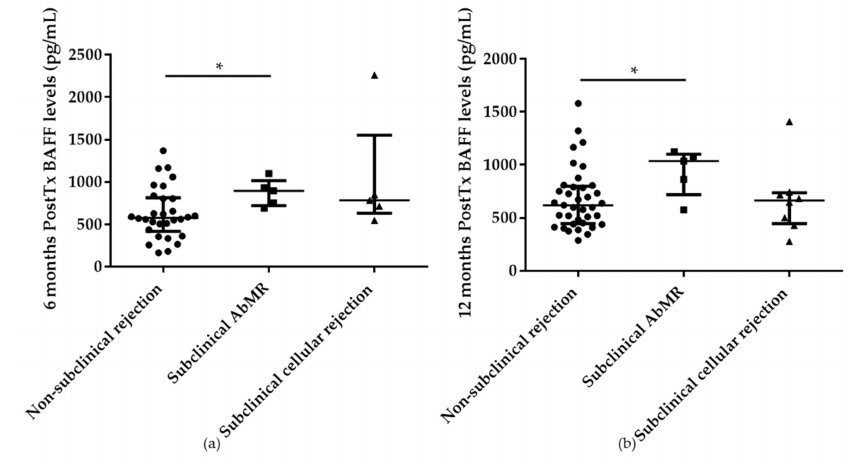
Figure 7. Higher BAFF serum levels at 6 ( a ) and 12 months ( b ) after kidney transplantation in patients with subclinical antibody-mediated rejection (AbMR; n = 5) detected retrospectively in the surveillance biopsy performed at 1 year after kidney transplantation, in comparison with non-rejection group ( n = 38). * indicates p <